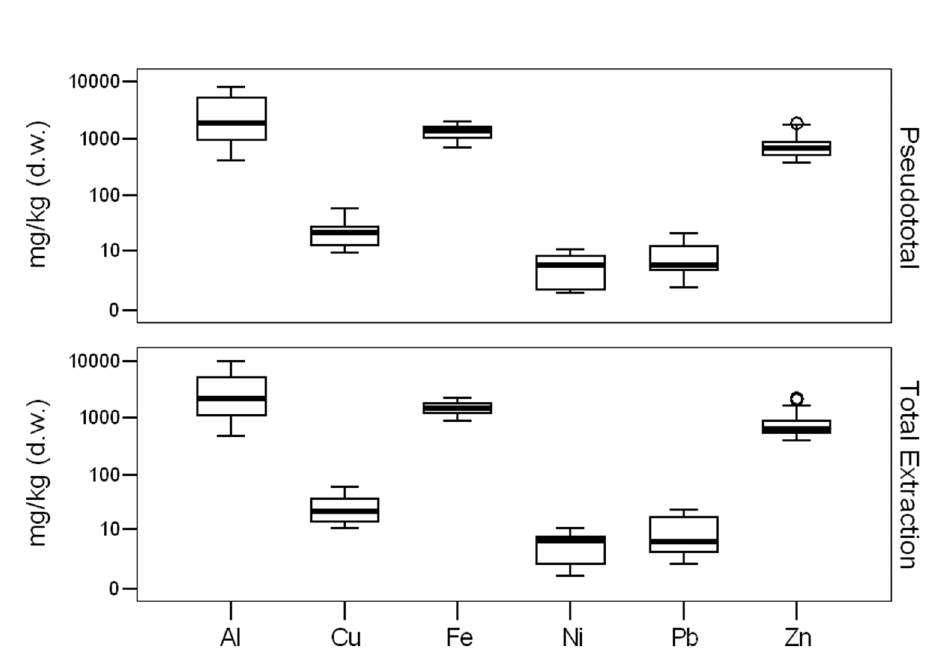
Table 2. Description of the soil from the urban sinkholes in the study. pH: a Neutral, b Acidic, c Basic. EC— electrical conductivity; Eas. Oxi. Org. C—Easily oxidized organic carbon; O.M.—Organic matter. Fe 2+ , Eas. Oxi. Org. and % O.M. mean value ± 1 s.d